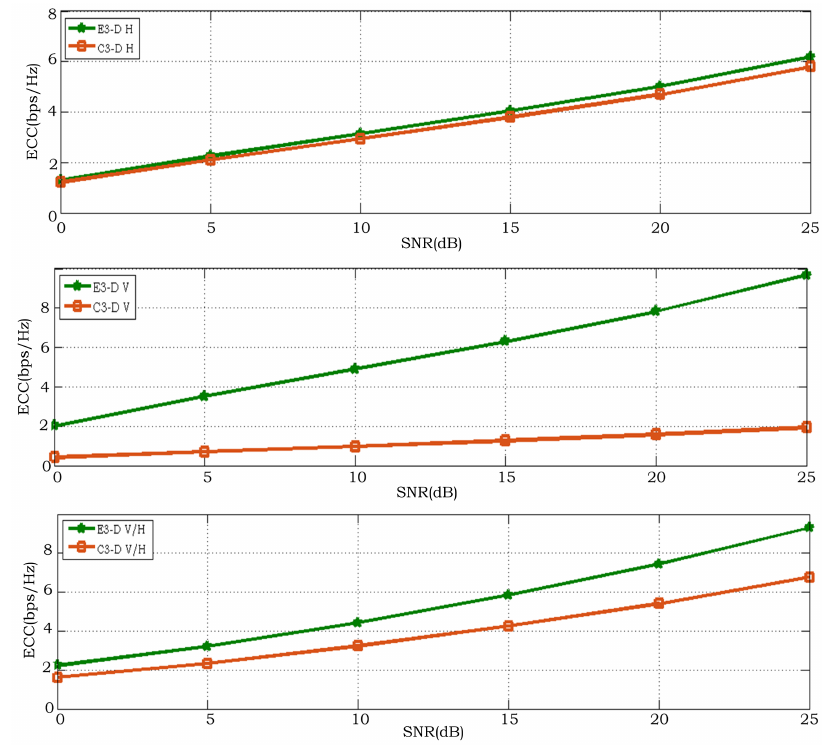
Figure 6. E3-D and C3-D compression capacity versus SNR for different